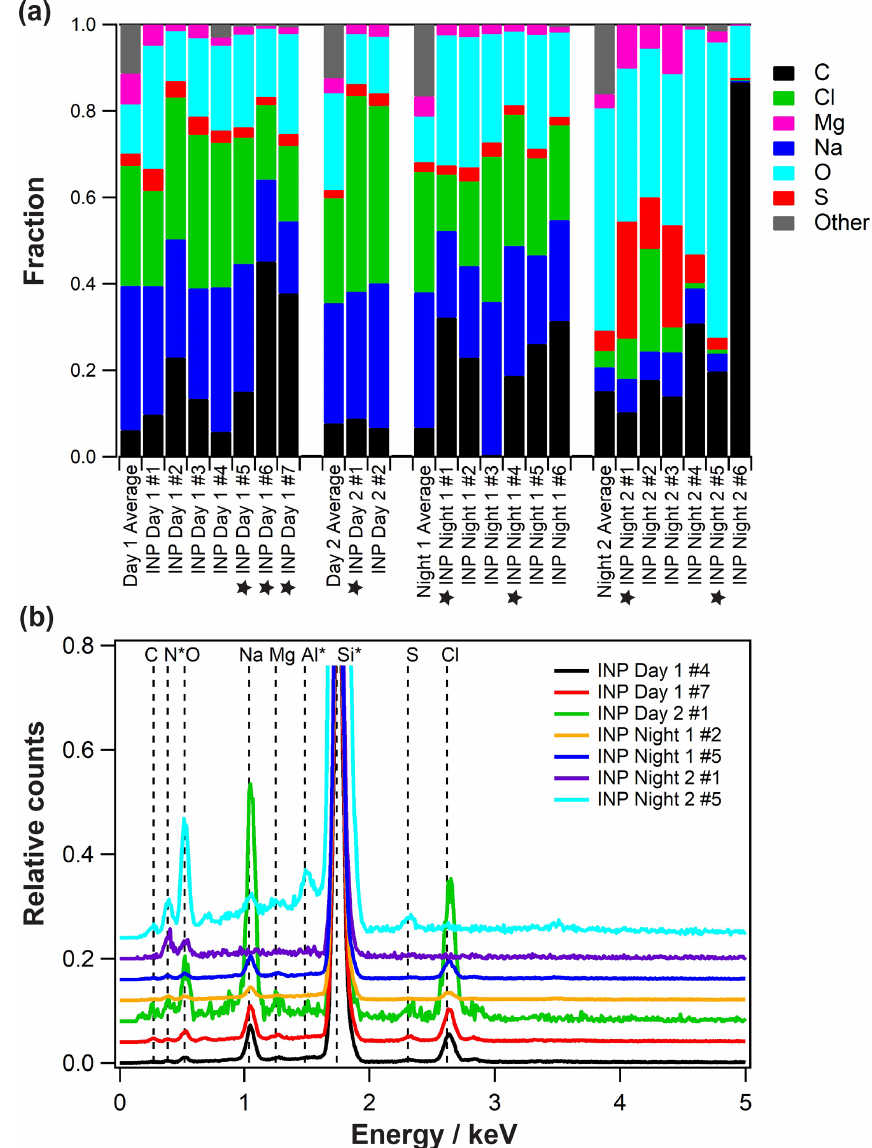
Figure 6. Composition of experimentally identified INPs. (a) Cumulative atomic percent of elements for 21 identified individual INPs is shown as bars for examined ACE-ENA particle samples. The first column represents the average cumulative atomic percent of elements for the specific particle sample. Stars indicate INPs shown in Fig. 5. Panel (b) shows representative EDX spectra of identified INPs. ∗ corresponds to the signal from the substrate (Si 3 N 4 -coated silicon wafer chips) and the chamber/holder